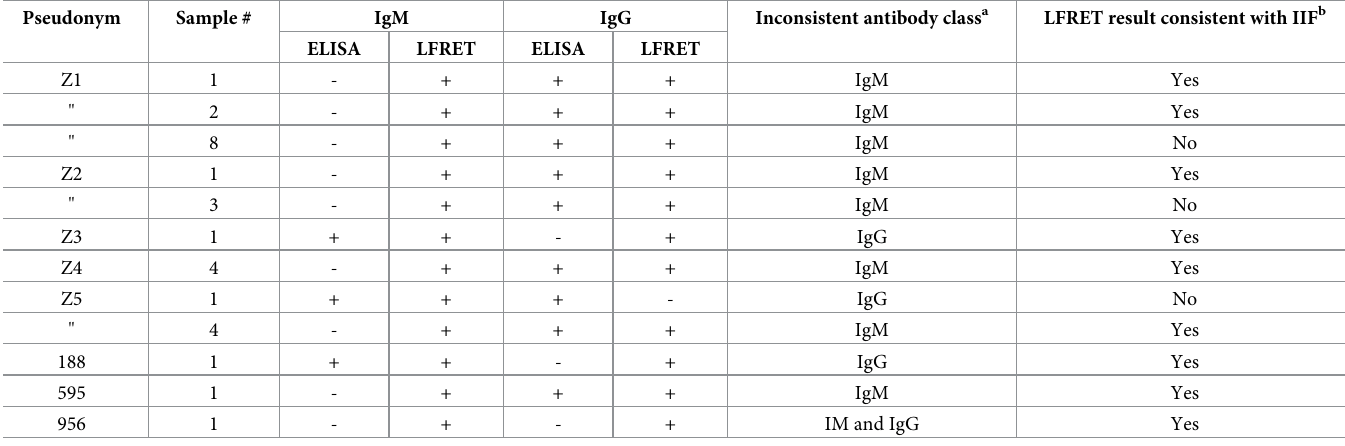
Table 6. The samples with inconsistent results between Euroimmun ELISA and class-specific LFRET